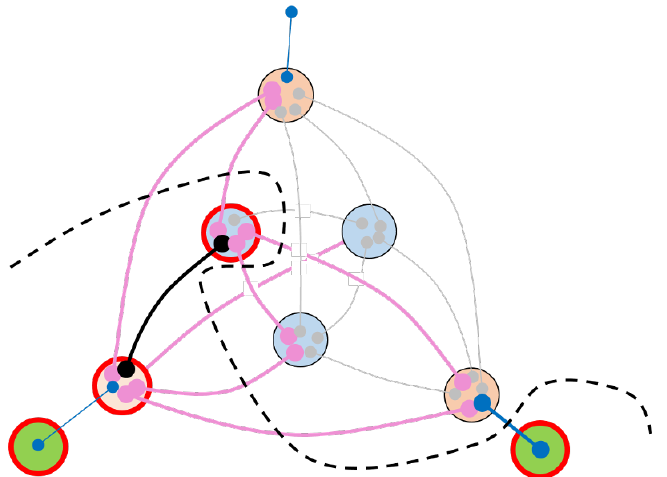
Figure 4 . Illustration of a spin con(cid:12)guration with n b = n B = 1. The spins are (cid:0) 1 for all sites with a thick red circle, and +1 elsewhere. The dashed line is the domain wall across which the spin changes sign. The contribution to the action comes from three kinds of links, those within the spin down region (black thick line), those between opposite spins (pink thick line) and those connecting the spin up boundary sites to the boundary (blue thick line). These three contributions correspond to A 1 ; 2 ; 3 in eq. (3.10)